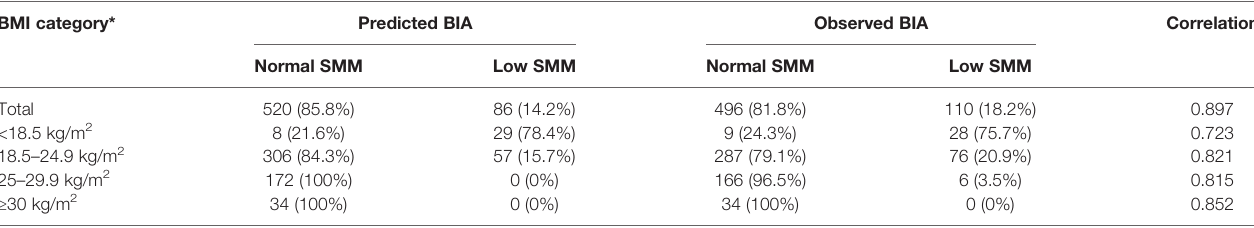
BMI, body mass index; BIA, bioelectrical impedance analysis; SMM, skeletal muscle mass. * BMI category: underweight, <18.5; normal weight, 18.5 – 24.9; overweight, 25 – 29.9; and obese, ≥